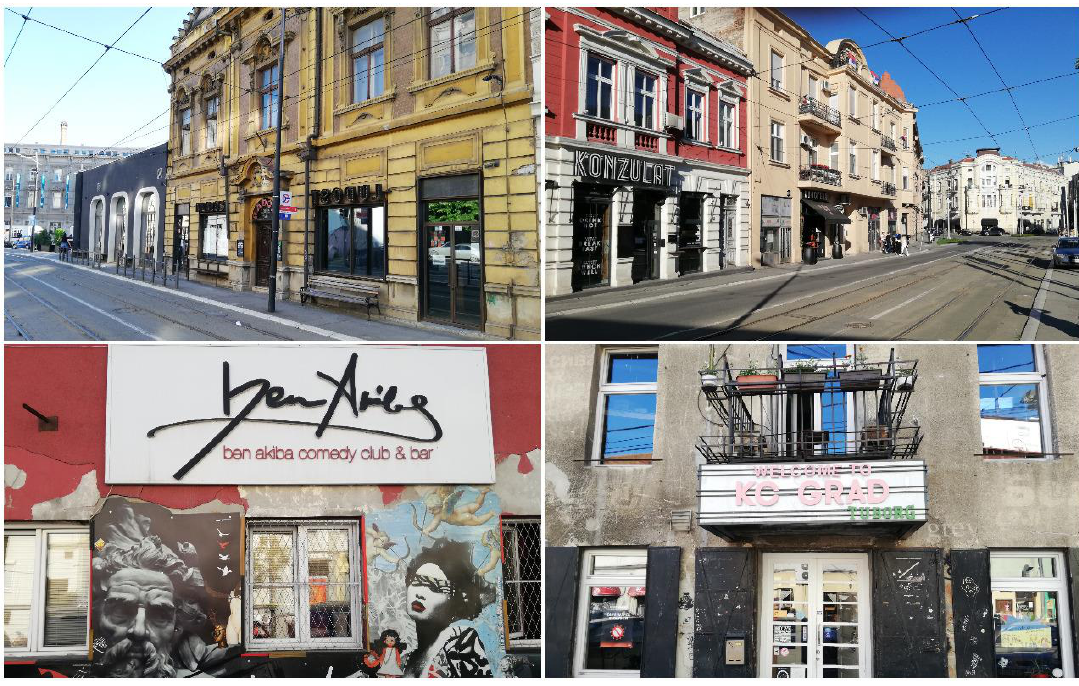
Figure 5. Clubs and bars in Savamala and KC Grad as one of still existing representatives of the cultural